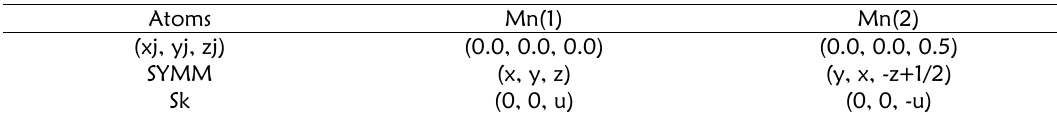
Table 10. Basis functions of Representation IRrep (1) of LaMnO 3 , space group: R-3c, magnetic symmetry (SYMM),